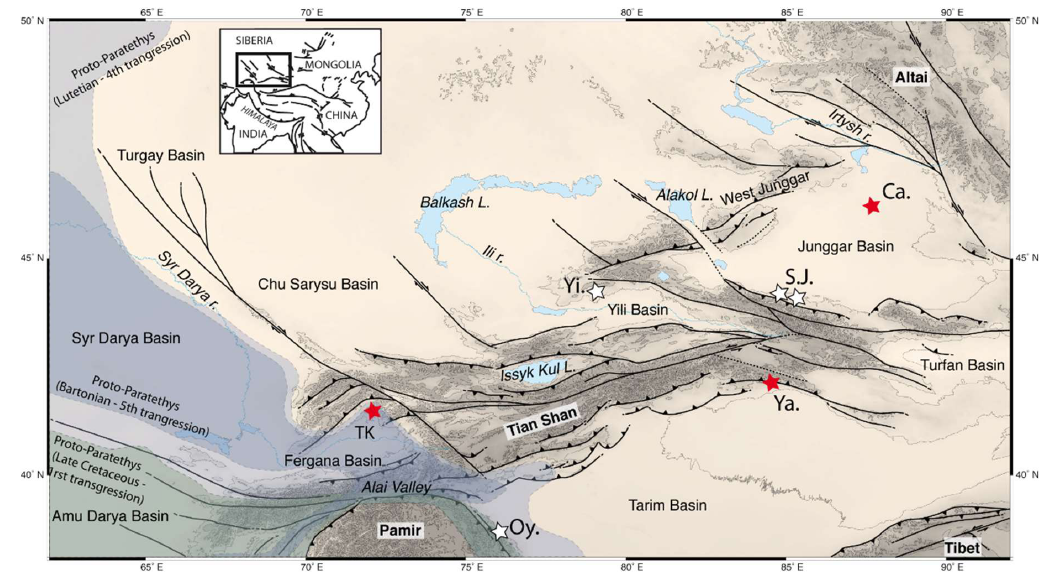
Figure 1. General topographic and structural map of the region surrounding the Tian Shan Range. The red stars indicate the location of the sections studied in this work (TK: Tash Komyr, Ca: Central Junggar Canyon, Ya: Yaha (this study and [16])); the white stars indicate the location of data obtained from the literature (S.J.: South Junggar [15,16], Oy.: Oytag [12], Yi.: Yili Basin [17]). The blue and green shaded areas represent the various incursions of the proto-Paratethys sea (modified from [10]). The oxygen and carbon isotope signatures of sediment deposits have already been used in the Tian Shan region to try to better constrain its topographic [12,15] and climatic evolution [17,18]. Pedogenic carbonates form in semi-arid to arid climates characterized by precipitations lower than 100 cm·yr −1 [19–21]. The 18 O of soil carbonates is controlled by the 18 O of soil water, itself primarily depending on the 18 O of meteoric water (e.g., [22]) brought either from in situ rainfall or possibly from rivers. Meteoric water 18 O is governed by isotopic fractionation in the atmosphere, the 18 O value decreasing with latitude and altitude following the decrease in atmospheric temperature, as